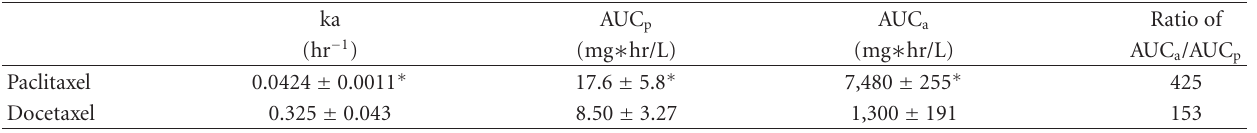
Table 2: The values of AUC of paclitaxel and docetaxel in plasma and ascitic fluid after an i.p. injection of Taxol and Taxotere into AH130 tumor-bearing rats [15].